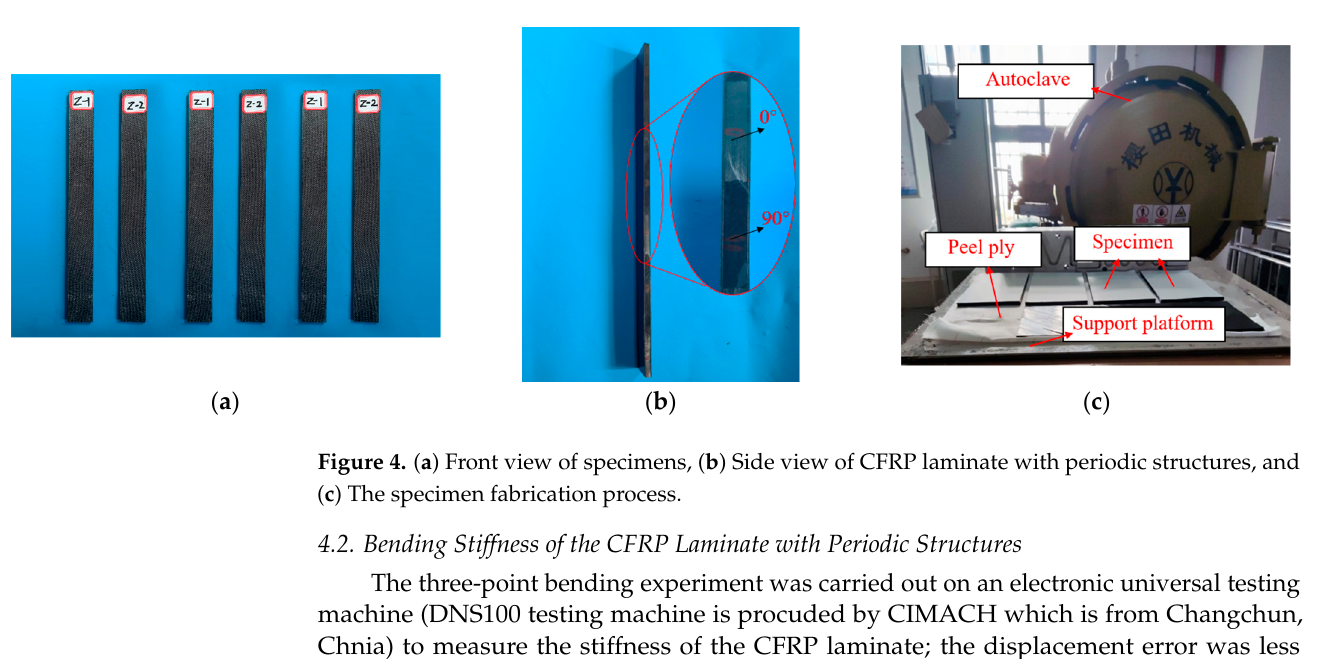
( b ) Figure 5. ( a ) Three-point bending experiment and ( b ) FEA model. The load and displacement curve after linear fitting is shown in Figure 6.